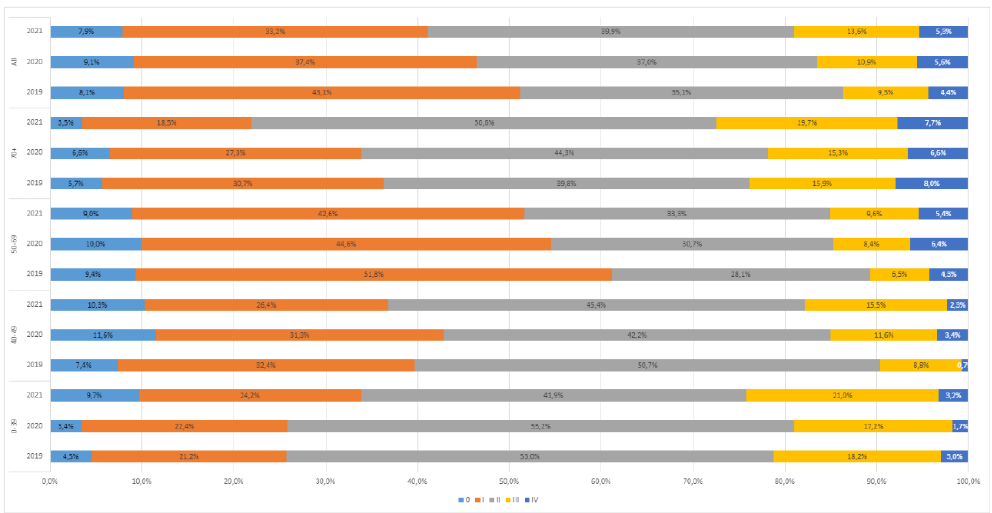
Figure 2. Percentage distribution of BC stages in years 2019 – 2021 by year and age group. Table 5. BC cases in years 2019 – 2021 divided into age group.